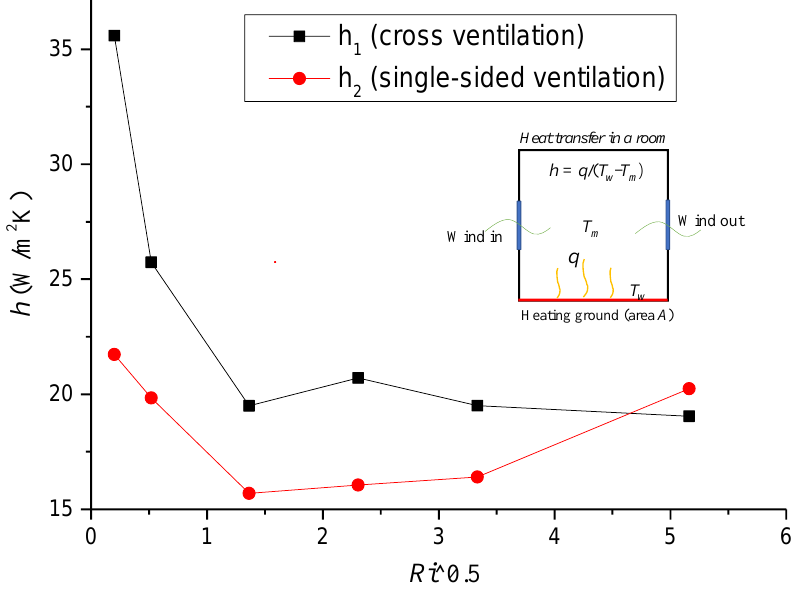
Figure 13. Mean h plotted against the square Ri numbers for cross- and single-sided ventilation cases.